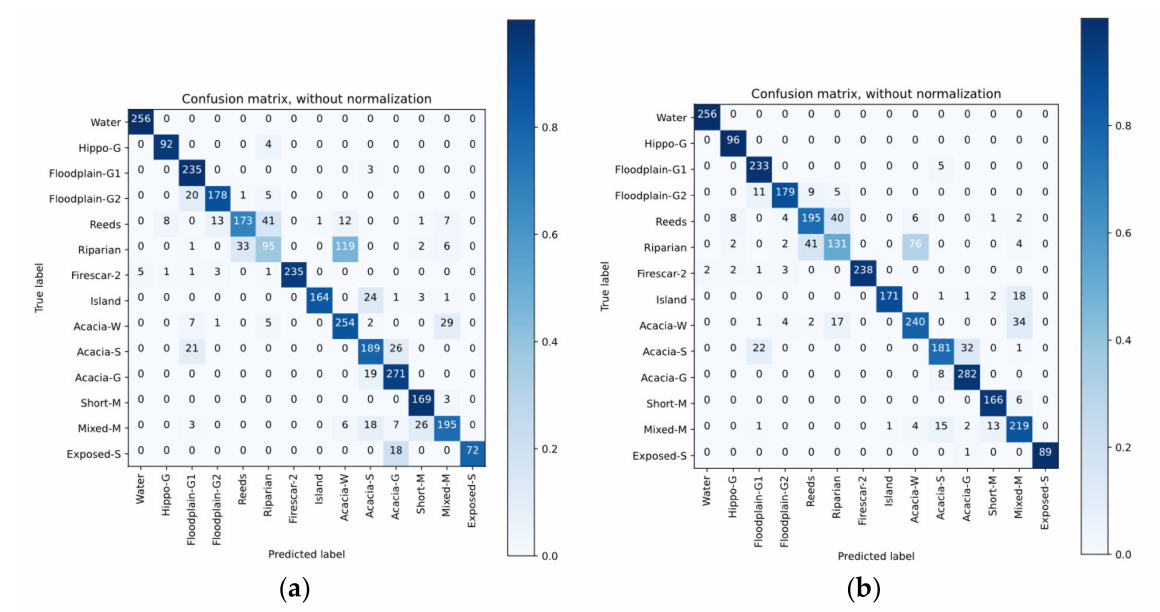
Figure 11. Comparison of confusion matrix under Botswana 5% training data: ( a ) CNN spe ( b ) CNN SFMF